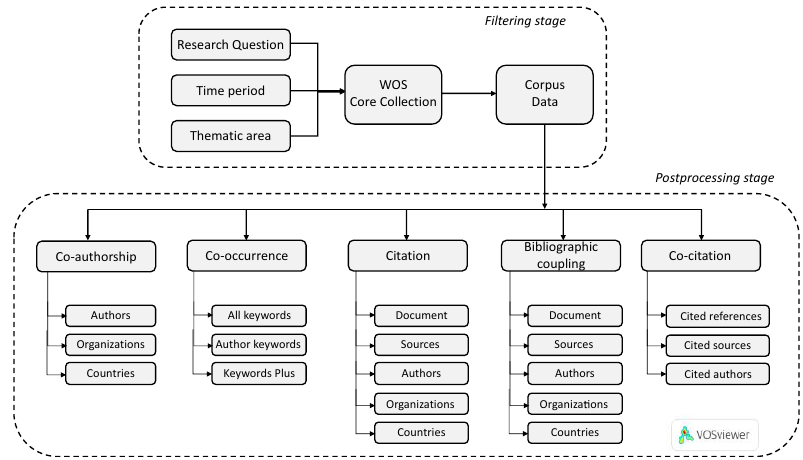
Figure 1. VOSviewer options for bibliometric and networking analysis [26].